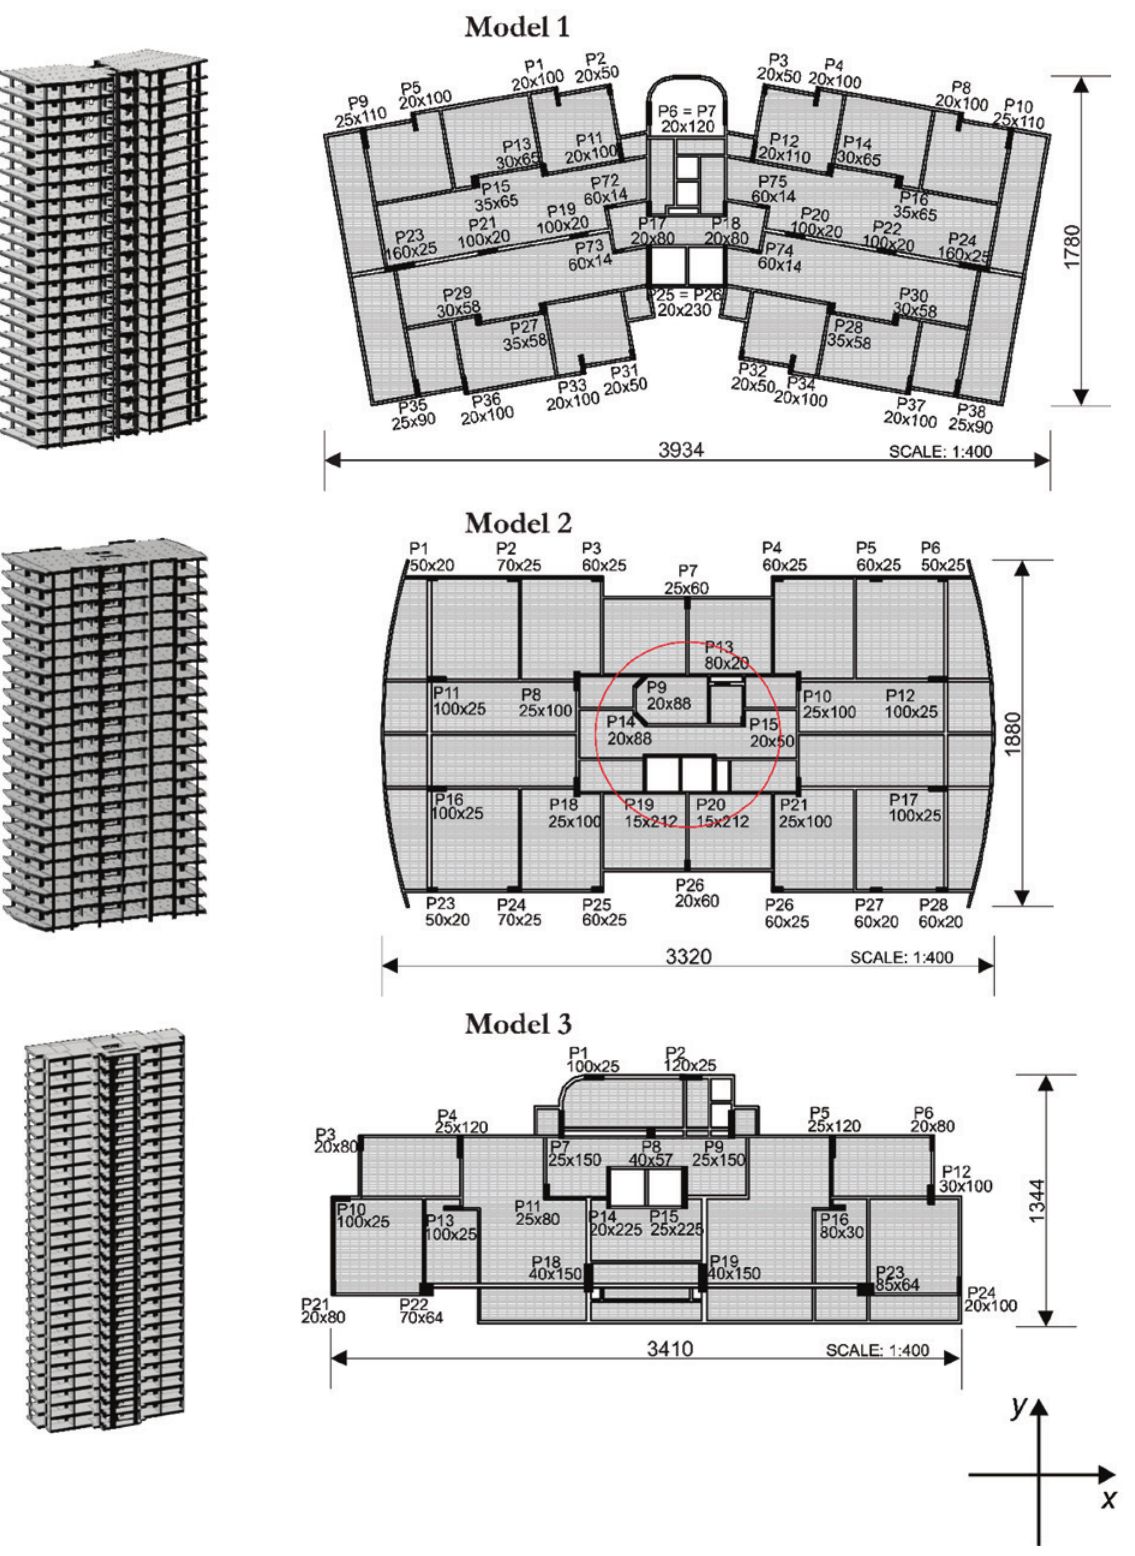
Figure 2 Models 1, 2 and 3